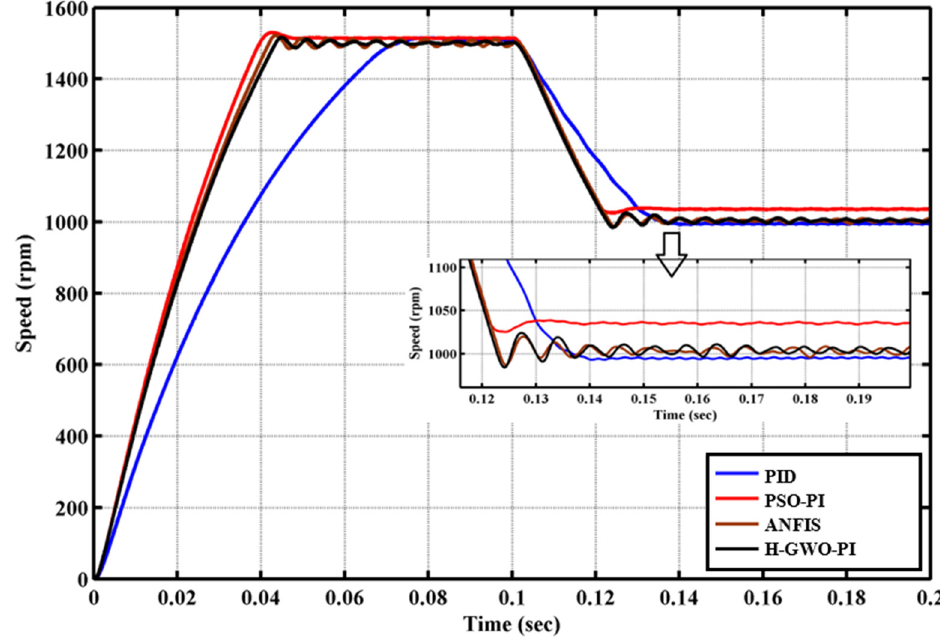
Figure 13. Response of the Brushless DC motor in terms of speed under Case C. Table 5. Performance parameters for Case C condition.